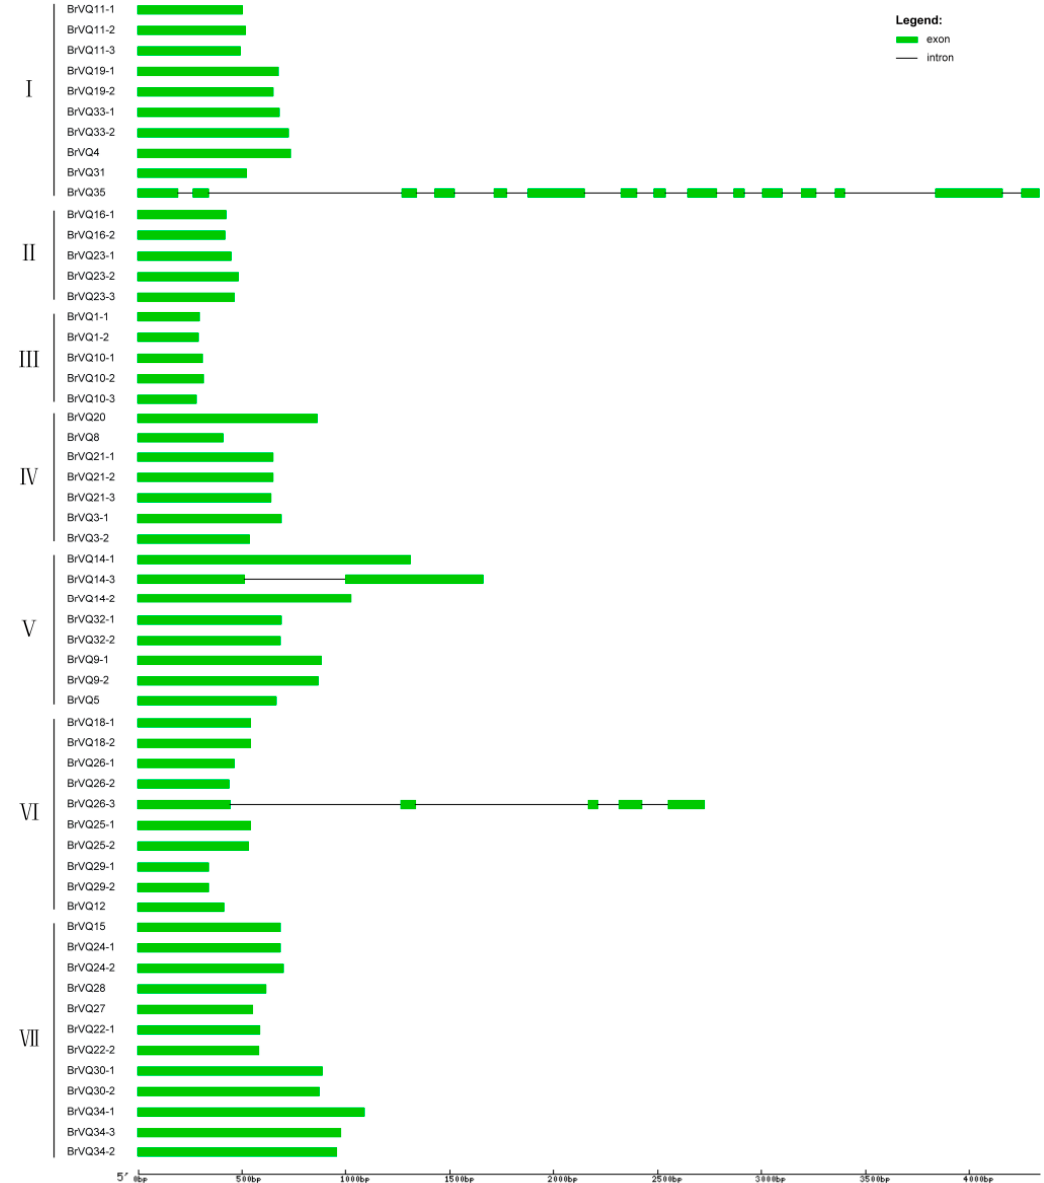
Figure 2. Intron and exon structure of the VQ genes in Chinese cabbage. The majority of the BrVQ genes only have one exon, except BrVQ14-3 , BrVQ26-3 , and BrVQ35 , which have one, four, and 14 introns, respectively.